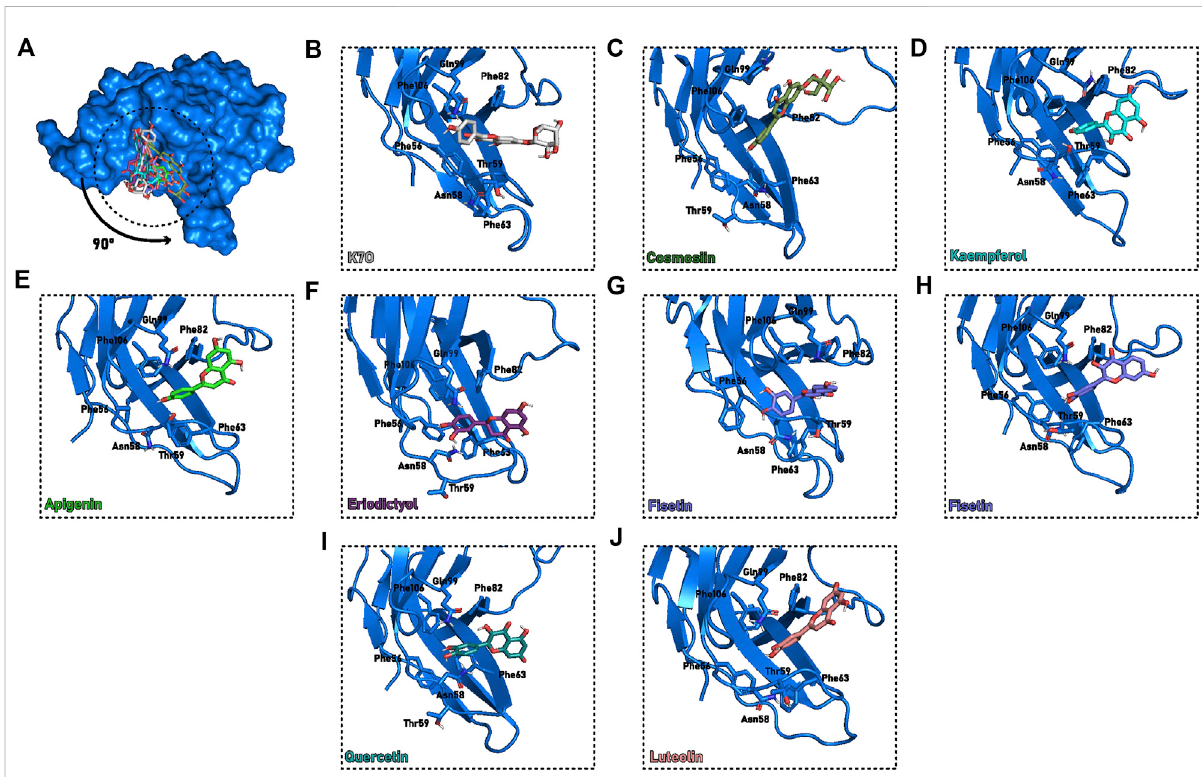
FIGURE 6 Proposed fl avonoids binding modes in cavity C3 PD − 1 at the end of the 50 ns cMD. (A) PD-1 (blue surface) with the molecules (sticks) superimposed to cavity C3 PD − 1 . (B – J) Detailed description of C3 PD − 1 binding cavity (blue cartoon) with the interacting residues and molecules highlighted(sticks).Theproteinorientationwasrotated90 ° comparedto (A) .Differentcolorswereassignedforeach fl avonoid: (B) Kaempferol-7-O- rhamnoside, or K7O, grey; (C) Cosmosiin, dark green; (D) Kaempferol, cyan; (E) Apigenin, green; (F) Eriodictyol, purple; (G,H) Fisetin, blue; (I) Quercetin, teal; (J) Luteolin,